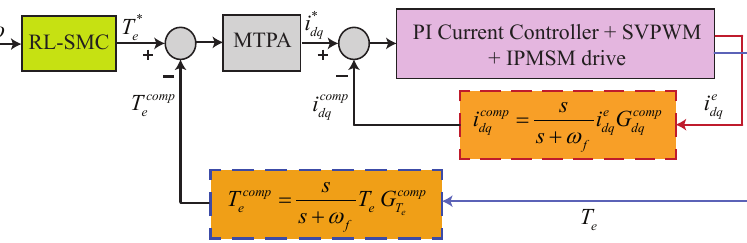
Figure 4. Structural diagram of proposed compensation scheme.